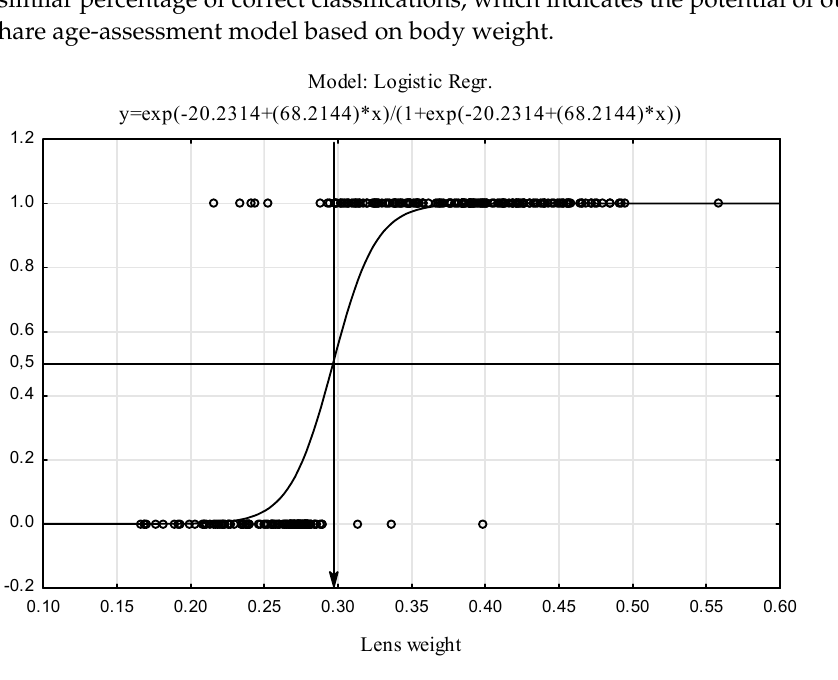
Figure 6 . Cutoff point for classification of cases based on dry lens weight (1 = A, 0 = J)